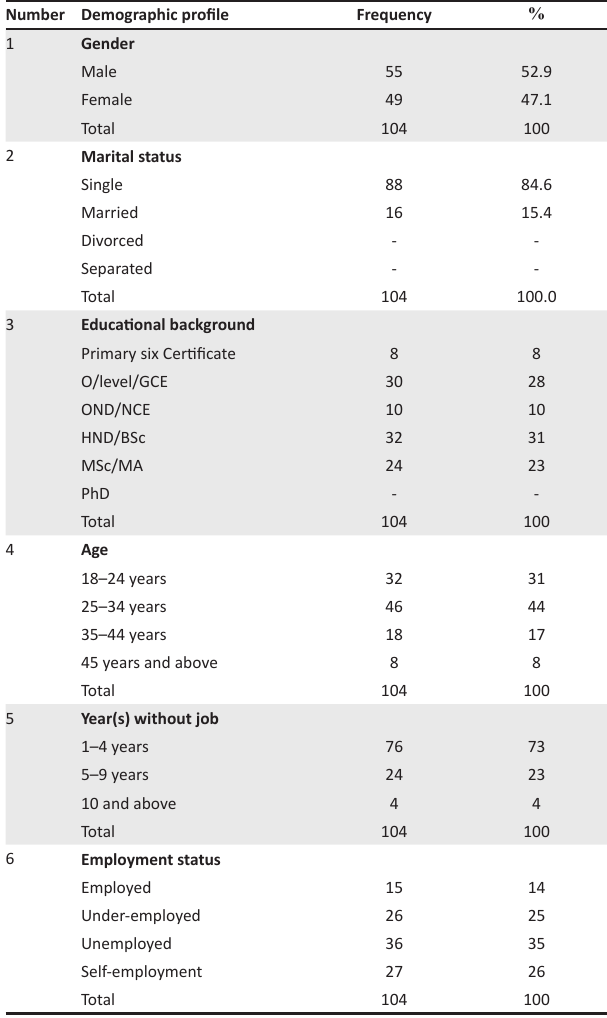
TABLE 1: Presentation of respondents’ demographic